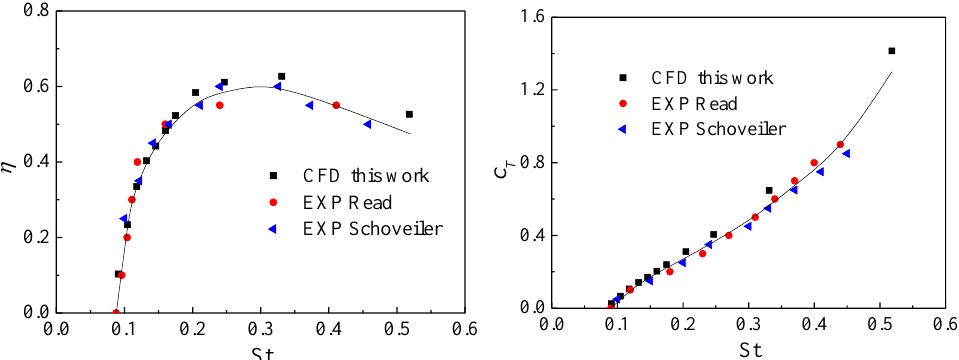
Figure 5. Comparisons of the propulsive efficiency η and the thrust coefficient c T with previous experimental results for a max = 20°.